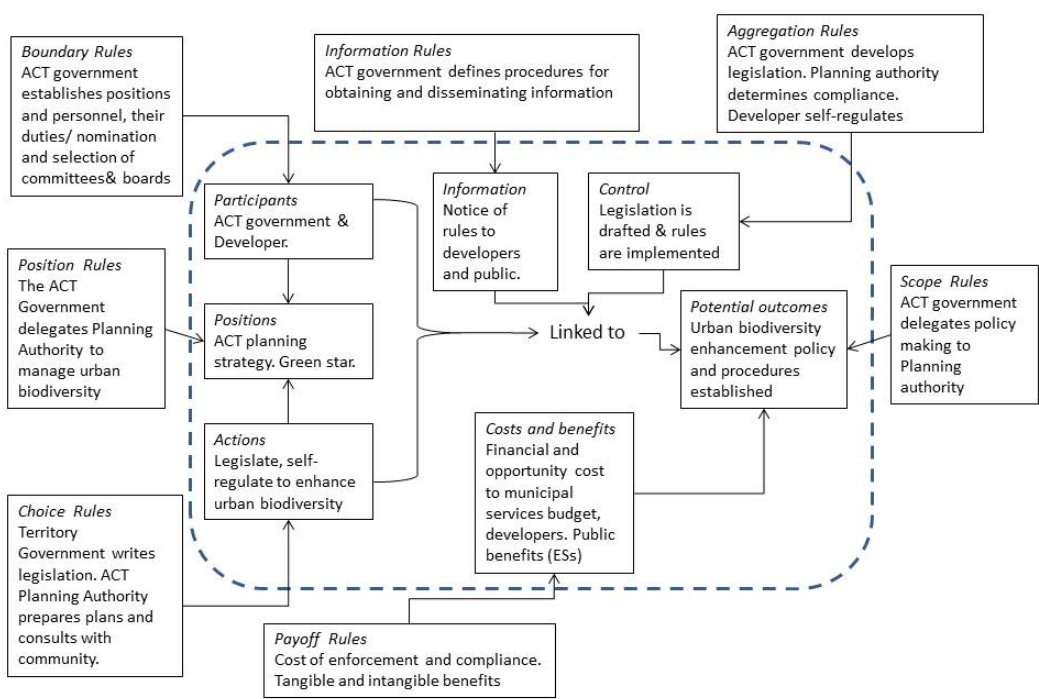
Figure 2. The IAD rules-in-use is applied to ecologically mature trees and map the institutions related to operational level management of urban open space. Adapted from Ostrom [32].